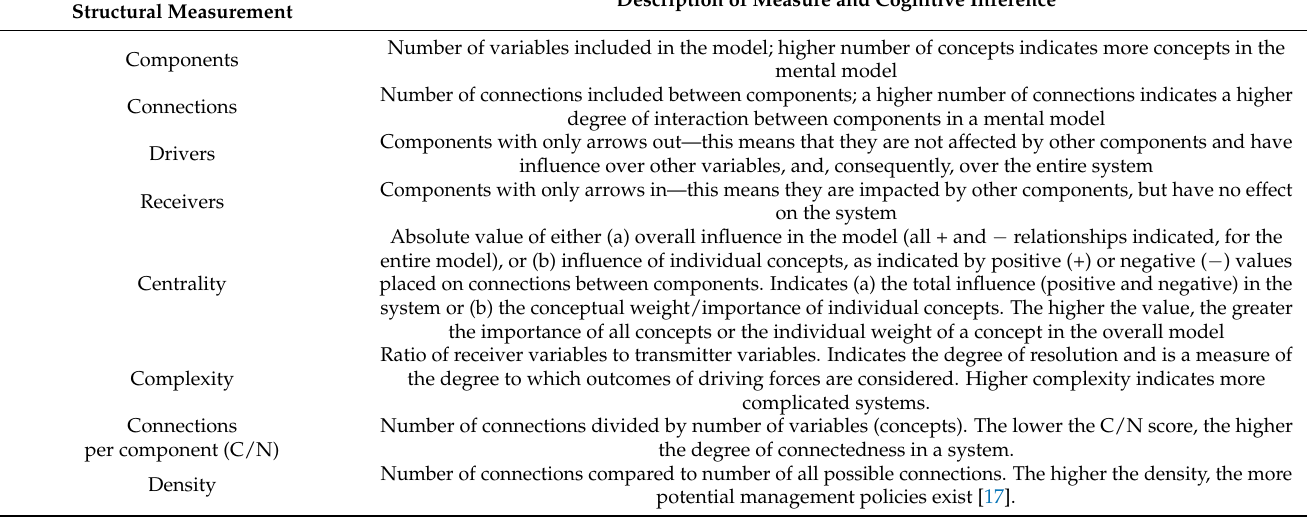
Table 1. Structural metrics applied to matrix forms of fuzzy cognitive maps to quantify structural properties of each expert’s perceived food web. Adapted from [12]. Mental Model, Description of Measure and Cognitive Structural Measurement